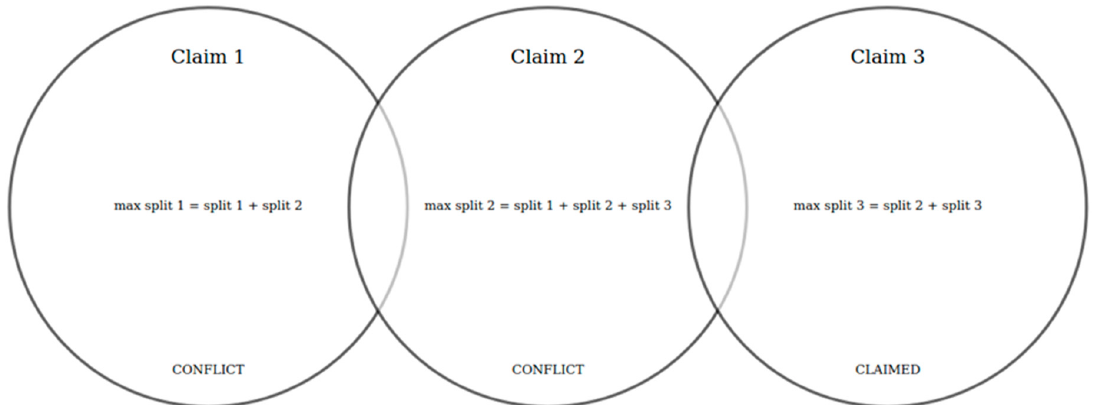
> 100, max split 2 > 100 and max